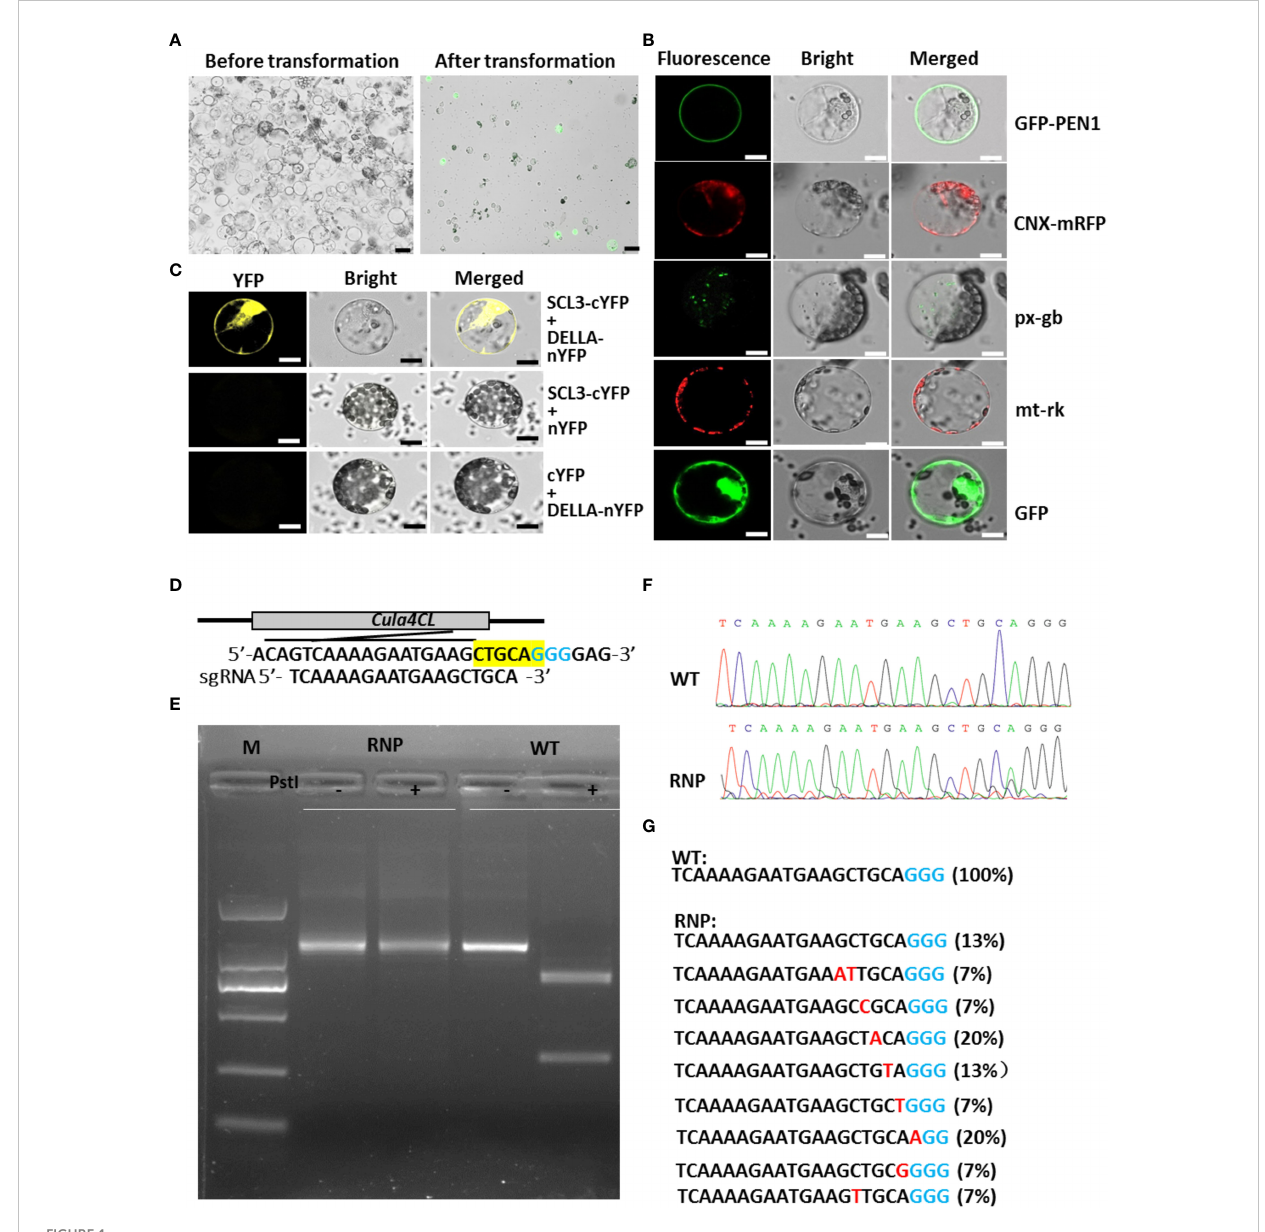
FIGURE 1 Protoplast isolation, transfection and gene function study in Chinese fi r. (A) Status of Chinese fi r protoplasts before (left) and after (right) transformation. Scale bar: 10 m m. (B) Subcellular localization of various cell organelle markers on plasma membrane ( PEN1-GFP ), ER ( CNX-mRFP ), peroxisome ( px-gb ), mitochondria ( mt-rk ) and control ( 35S:GFP ) in Chinese fi r protoplasts. Scale bar: 10 m m. (C) BiFC assay showing the interaction between CulaSCL3 and CulaDELLA in Chinese fi r protoplasts. Scale bar: 10 m m. (D) Schematic of the Cula4CL gene with the RNP targets (bottom). The corresponding PAMs (blue) and PstI site were highlighted (yellow). (E) PCR/RE assay to detect engineered RNP-induced mutations in protoplasts. (F) Sequencing of the PCR products from wild-type and RNP-delivered samples. (G) Mutation types and frequencies of RNP-delivered protoplasts. PAM (blue) and indels (Red) are shown; the ratios of certain indel type are shown in